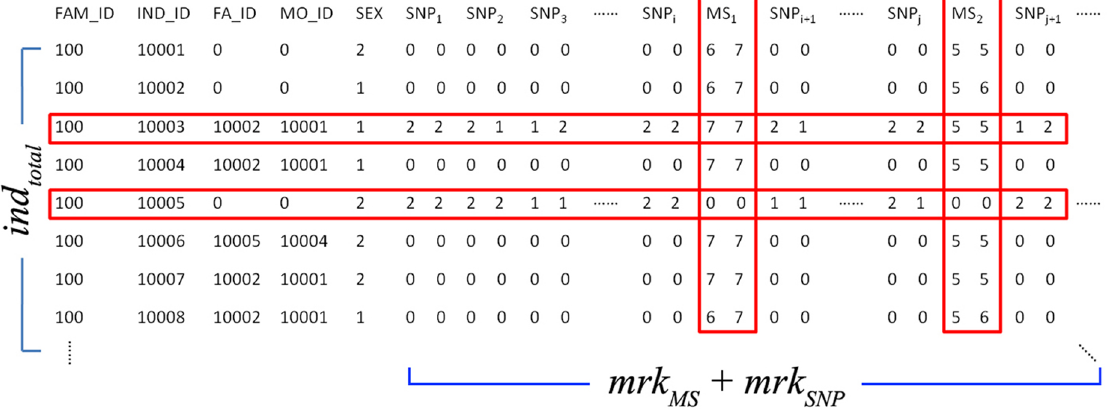
Figure 2. Combined pedigree structure used in inference. The pedigree has ind total individuals and ( mrkMS + mrk SNP ) markers. Most individuals have been genotyped on microsatellite markers. ind common out of ind total individuals are selected for SNP genotyping. Microsatellite and SNP markers are mapped based on their genetic positions. Missing SNPs of ( ind total - ind common ) will be inferred by MERLIN –infer.